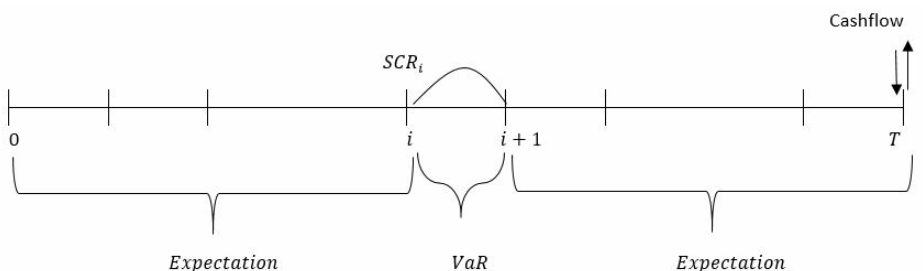
Figure 4. Computation of the successive SCR i at time 0 in our